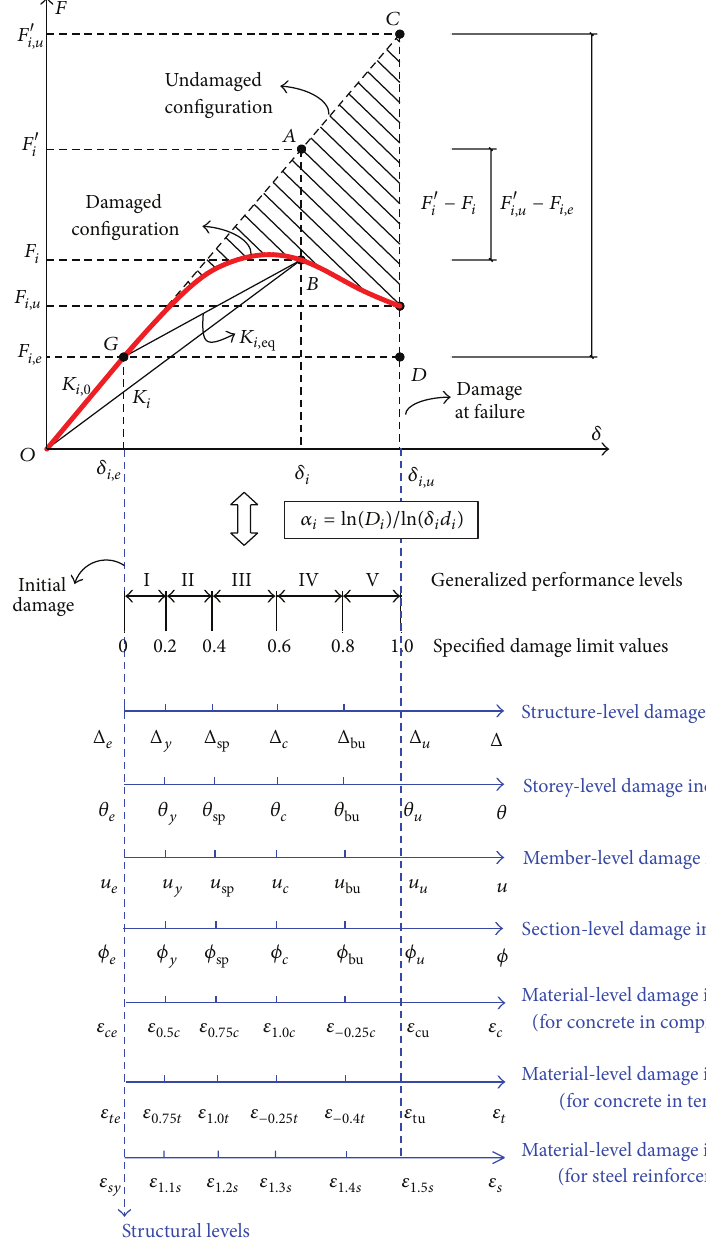
Figure 5: Generalized damage model combined with multiperformance levels.